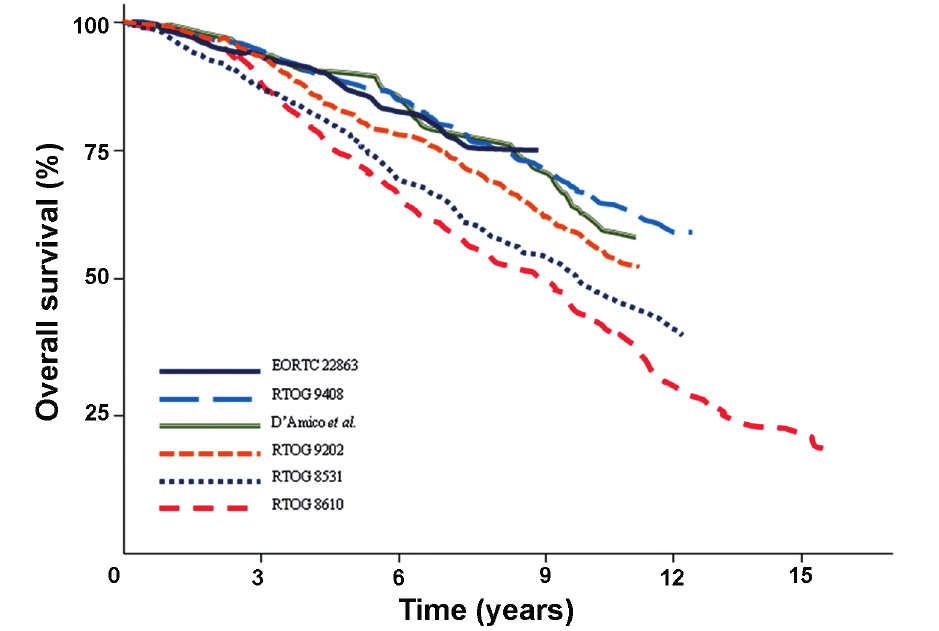
Figure 1 – Overall survival curves of the combined treatment arms (radiation therapy plus androgen deprivation therapy), not strati- fied for risk groups, from the EORTC 22863 (48), RTOG 9408 (43), D’Amico et al. (40), RTOG 9202 (50), RTOG 8531 (46) and RTOG 8610 (37)